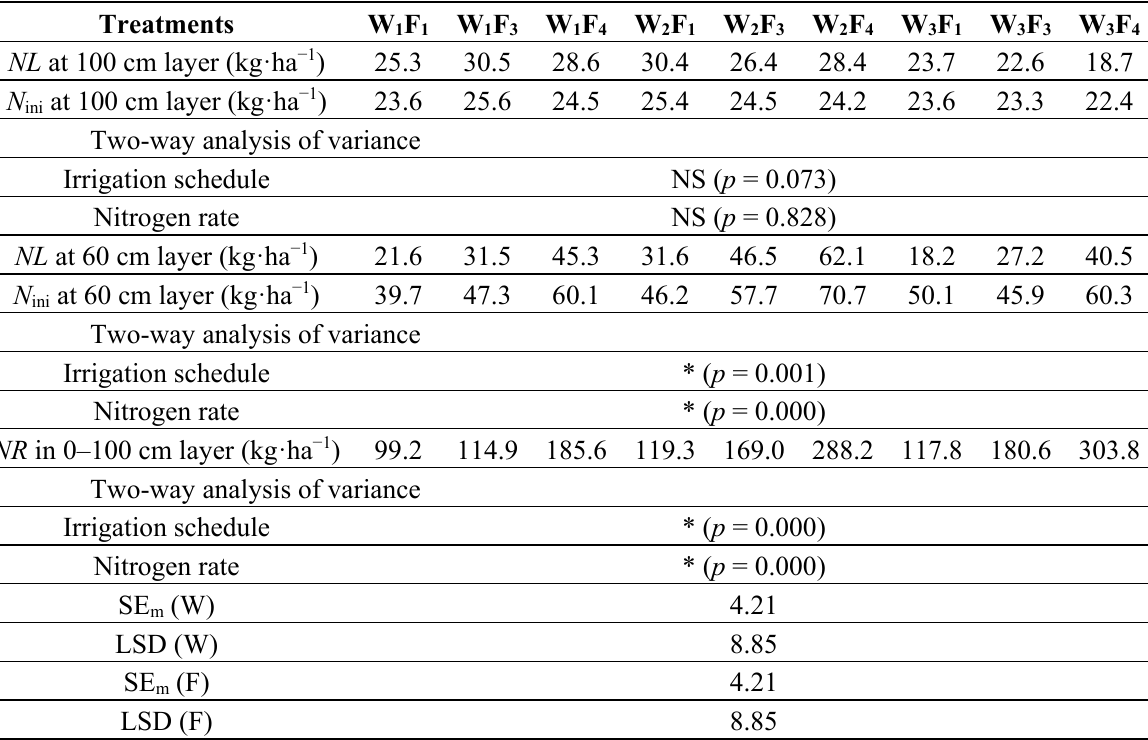
Table 7. Nitrate leaching (NL), initial nitrate concentration (N ini ) and nitrogen residual (NR) for all treatments during the wheat season of